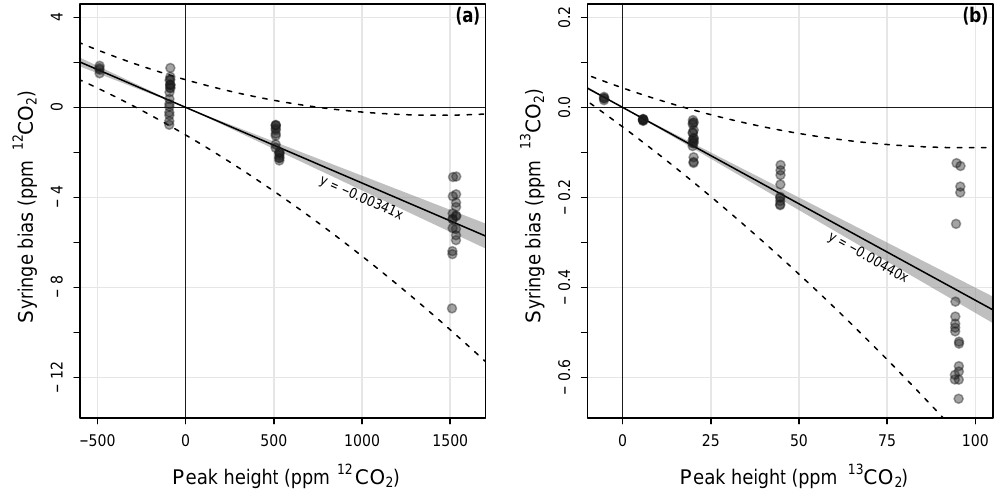
Figure 4. Discrepancies between syringe sample and direct bottle measurements (syringe bias) of gas standards as a function of the syringe sample peak height (Eq. 7) for (a) x 12 CO 2 and (b) x 13 CO 2 . The WLS-fitted linear models (see Sect. 2.3) are overlaid for comparison (solid lines, slopes = 1 − K , Eq. 7), with 95% confidence intervals (shaded) and 95% prediction intervals (dashed lines) as determined from the standard error estimates of K C12 and K C13 (Sect.